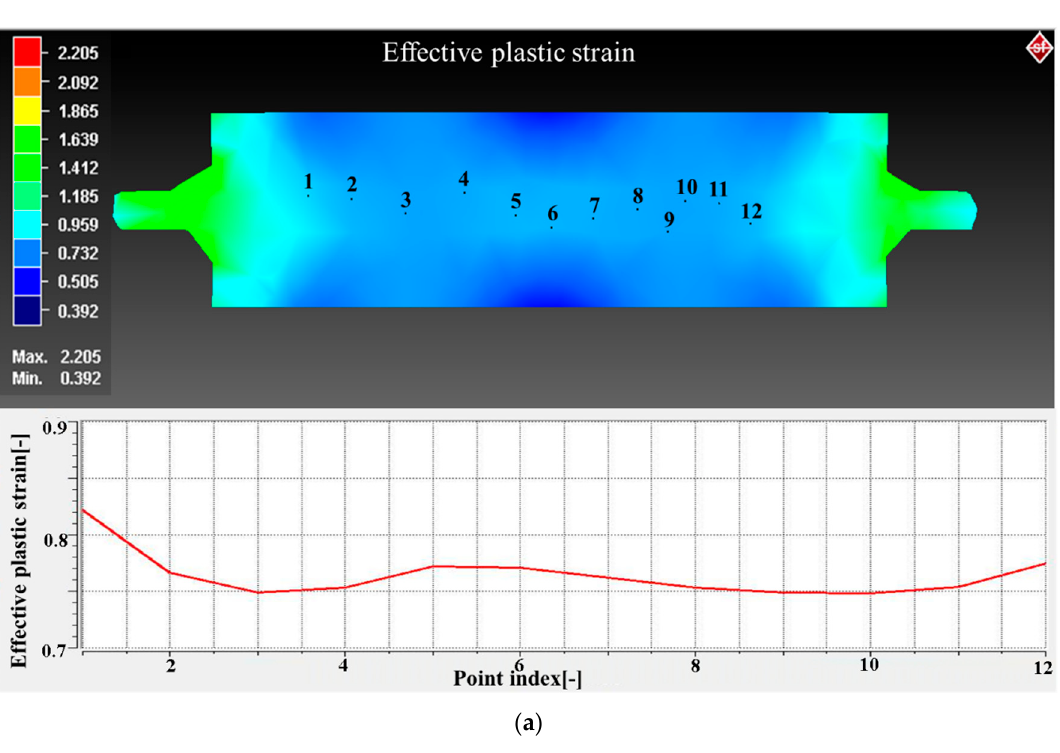
Table 2. Measured tensile properties for hot-forged (HC) and subzero-treated (SO) samples.